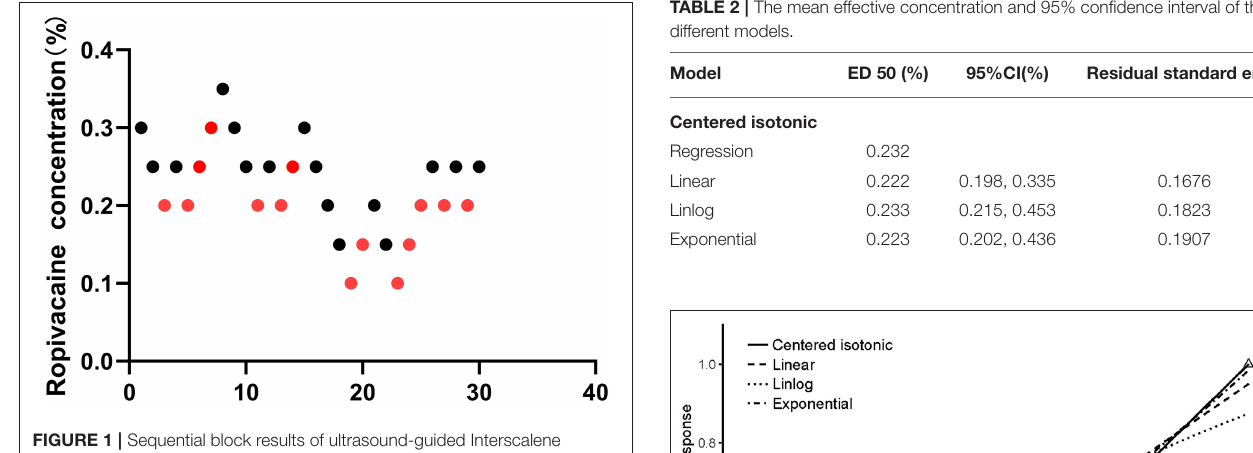
TABLE 1 | Patient characteristic.